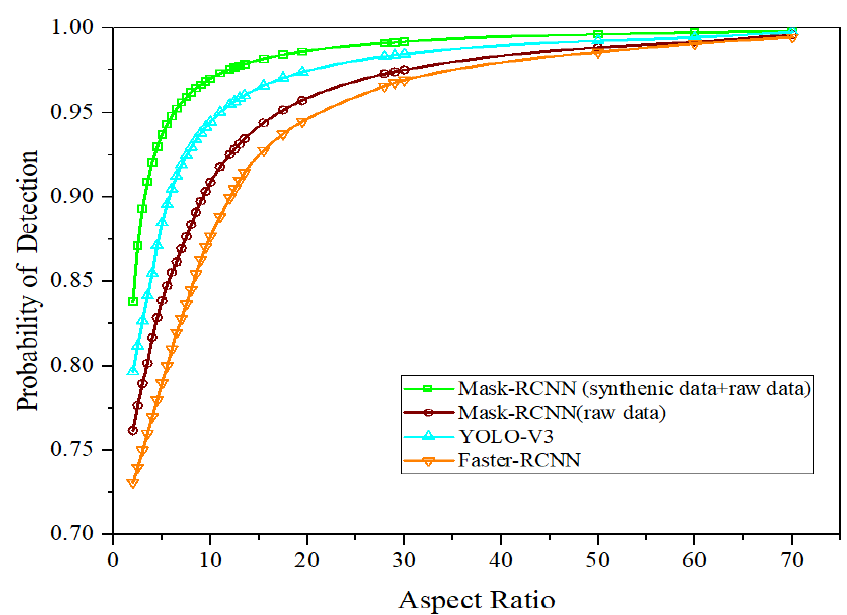
Figure 14. Probability of distribution of different deep learning methods on CFRP databases (confidence score = 0.75). Table 2. Running time complexity comparison with state-of-the-art methods.